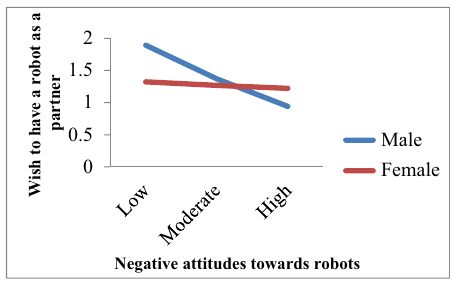
Figure 3: Gender as moderator of the relationship between Negative attitudes toward robots and a Wish to have a robot as a partner. Gender is coded as dummy variable with values 0 = male, 1 = female. Note. The y - axis represents the average ratings on the item “ Wish to have a robot as s partner. ”